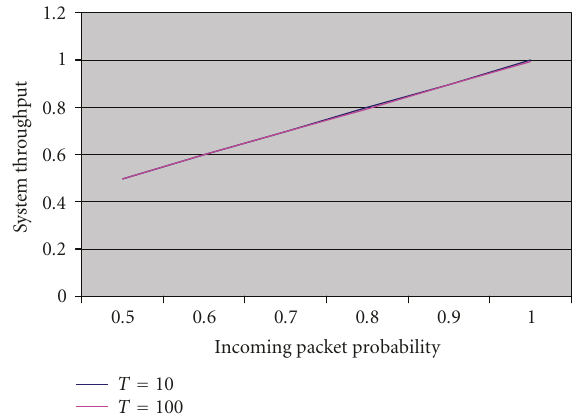
Figure 15: Average bu ff er occupancy versus incoming packet prob- ability ( T = 10,100).